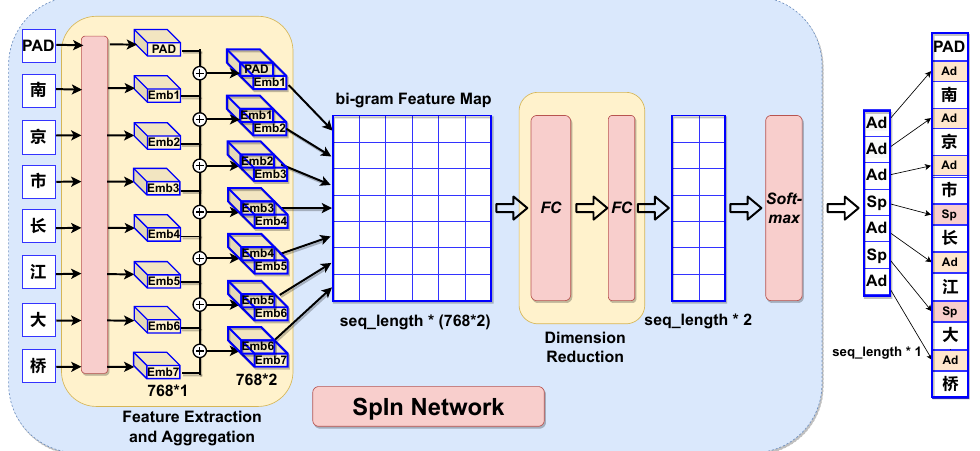
Figure 3. The network of Separation Inference. The Chinese sentece indicates “Nanjing Yangtze River